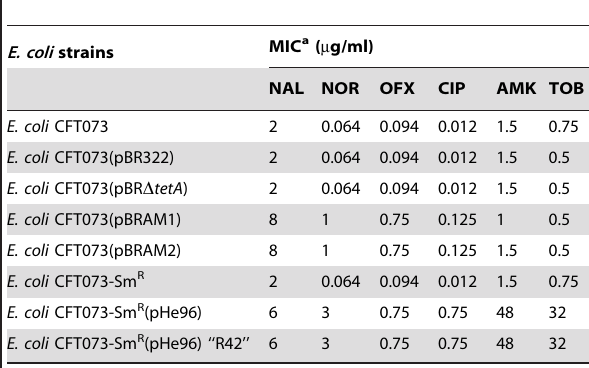
Table 1. Minimal Inhibitory Concentrations (MIC) of quinolones against the strains of the two isogenic systems derived from E. coli